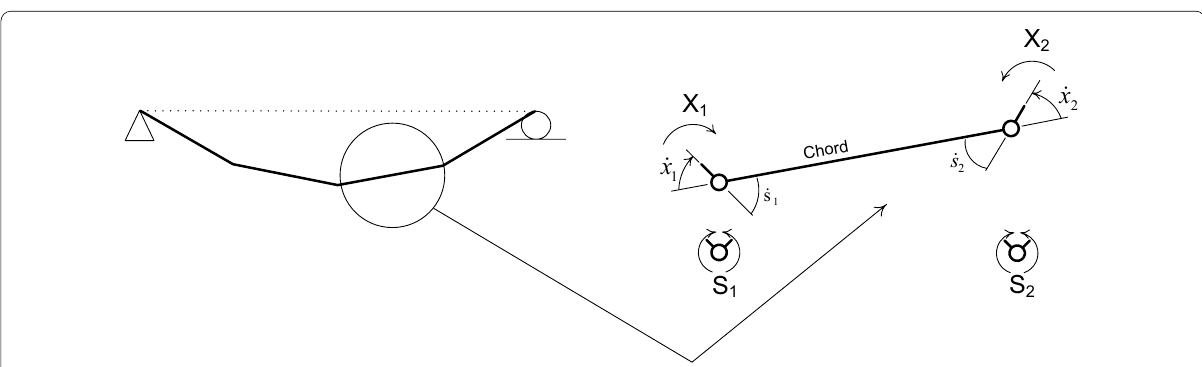
Fig. 1 Stress-resultants, strain-resultant rates, chord deformation rates and independent chord